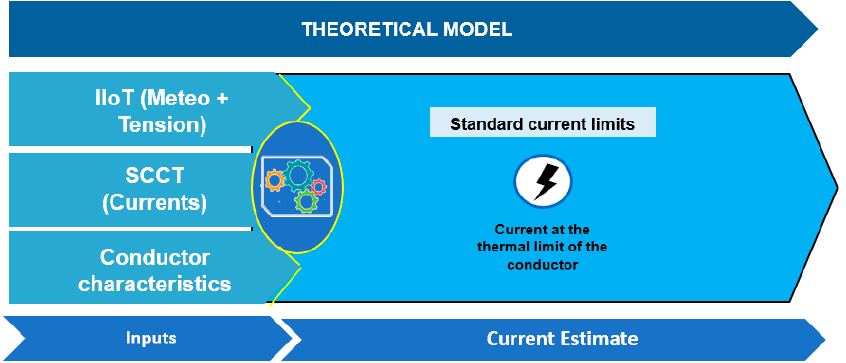
Figure 9 . Theoretical model for ampacity estimation.